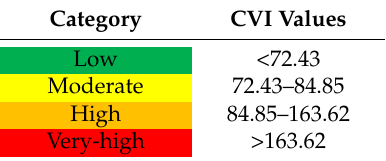
Table 2. Vulnerability